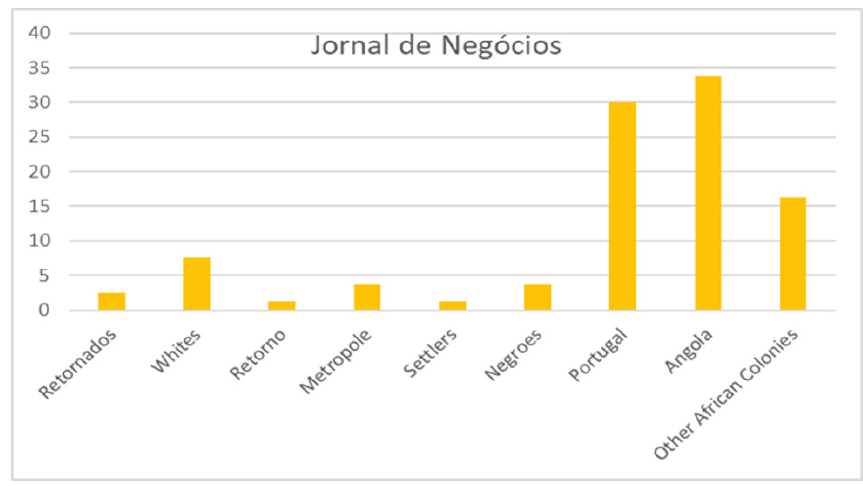
Figure 15. Most frequent words in the text “25 de Abril: Retornados contam história 40 anos depois”. Source: Jornal de Negócios (2014) [28].